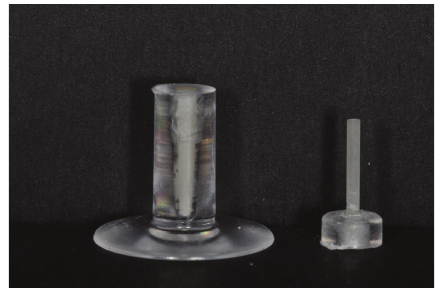
Figure 2: Sample after cutting slice for pull-out